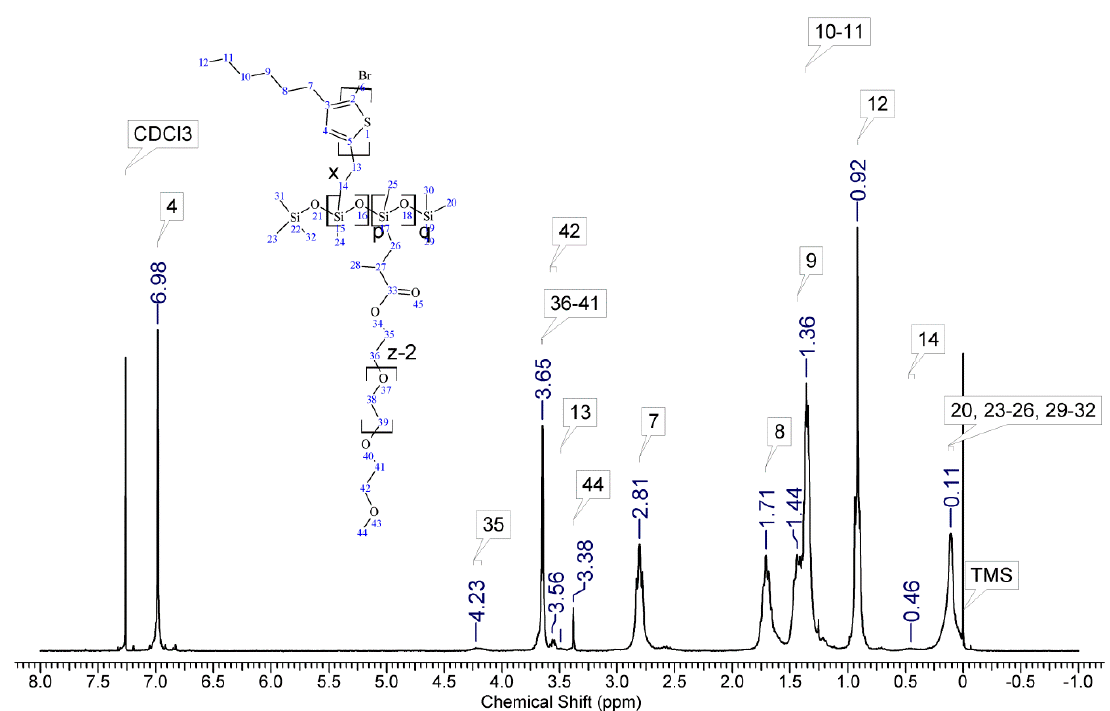
Figure 1. 1 H-NMR spectrum of poly(methylhydrosiloxane)-graft-[poly(3-hexylthiophene); poly(ethylene glycol) methyl ether methacrylate] (PEG M n ≈ 500) (SilPEG 1.2).